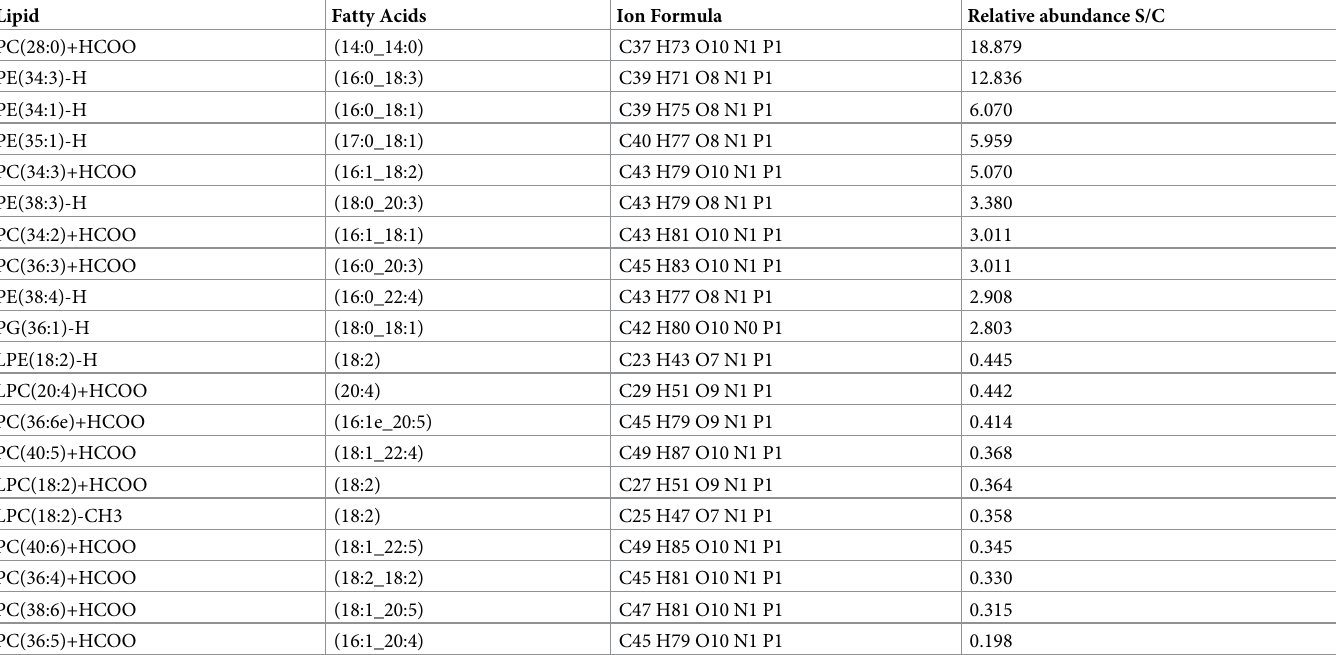
Table 6. Top 10 lipids upregulated and downregulated in dogs with sepsis C30 negative ion mode. Lipid Fatty